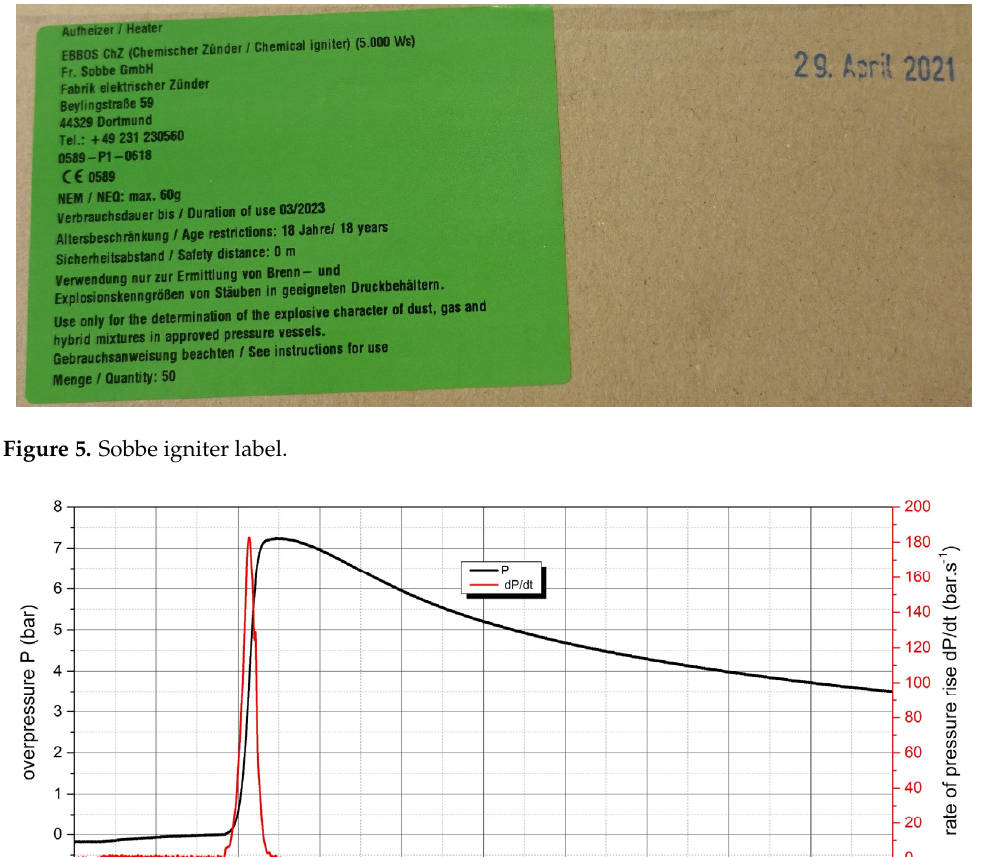
Figure 6. Overpressure P and rate of pressure rise dP/dt of 250 g·m − 3 Lycopodium clavatum powder ignited by Igniter 1 (shelf life less than 1 year).